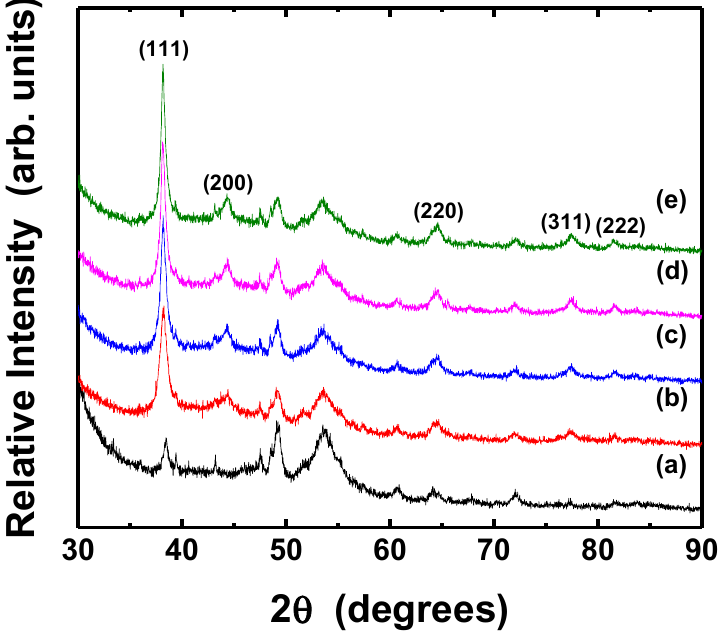
Figure 9. XRD patterns of Ag thin films post-treated for various durations: ( a ) PET substrate, ( b ) as- deposited, ( c ) 10 min, ( d ) 30 min, ( e ) 50 min, respectively. All samples were thermally treated at 150 ◦